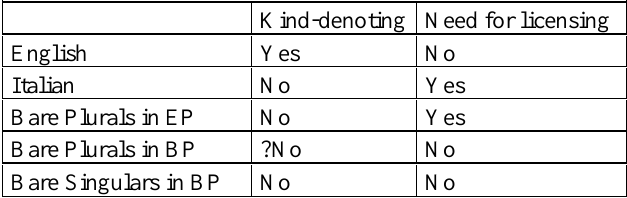
TABLE I: The behaviour of Bare Nouns Kind-denoting Need for